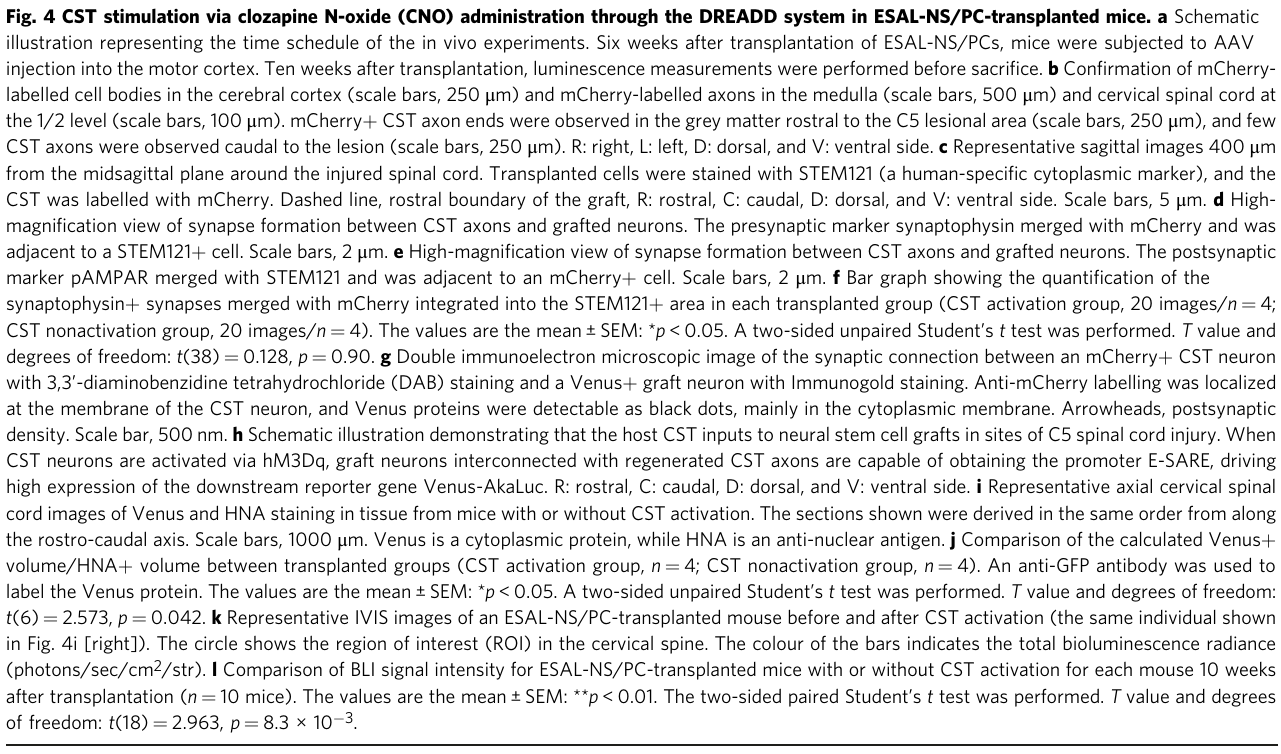
Fig. 4 CST stimulation via clozapine N-oxide (CNO) administration through the DREADD system in ESAL-NS/PC-transplanted mice. a Schematic illustration representing the time schedule of the in vivo experiments. Six weeks after transplantation of ESAL-NS/PCs, mice were subjected to AAV injection into the motor cortex. Ten weeks after transplantation, luminescence measurements were performed before sacri fi ce. b Con fi rmation of mCherry- labelled cell bodies in the cerebral cortex (scale bars, 250 μ m) and mCherry-labelled axons in the medulla (scale bars, 500 μ m) and cervical spinal cord at the 1/2 level (scale bars, 100 μ m). mCherry + CST axon ends were observed in the grey matter rostral to the C5 lesional area (scale bars, 250 μ m), and few CST axons were observed caudal to the lesion (scale bars, 250 μ m). R: right, L: left, D: dorsal, and V: ventral side. c Representative sagittal images 400 μ m from the midsagittal plane around the injured spinal cord. Transplanted cells were stained with STEM121 (a human-speci fi c cytoplasmic marker), and the CST was labelled with mCherry. Dashed line, rostral boundary of the graft, R: rostral, C: caudal, D: dorsal, and V: ventral side. Scale bars, 5 μ m. d High- magni fi cation view of synapse formation between CST axons and grafted neurons. The presynaptic marker synaptophysin merged with mCherry and was adjacent to a STEM121 + cell. Scale bars, 2 μ m. e High-magni fi cation view of synapse formation between CST axons and grafted neurons. The postsynaptic marker pAMPAR merged with STEM121 and was adjacent to an mCherry + cell. Scale bars, 2 μ m. f Bar graph showing the quanti fi cation of the synaptophysin + synapses merged with mCherry integrated into the STEM121 + area in each transplanted group (CST activation group, 20 images/ n = 4; CST nonactivation group, 20 images/ n = 4). The values are the mean ± SEM: * p < 0.05. A two-sided unpaired Student ’ s t test was performed. T value and degrees of freedom: t (38) = 0.128, p = 0.90. g Double immunoelectron microscopic image of the synaptic connection between an mCherry + CST neuron with 3,3 ’ -diaminobenzidine tetrahydrochloride (DAB) staining and a Venus + graft neuron with Immunogold staining. Anti-mCherry labelling was localized at the membrane of the CST neuron, and Venus proteins were detectable as black dots, mainly in the cytoplasmic membrane. Arrowheads, postsynaptic density. Scale bar, 500 nm. h Schematic illustration demonstrating that the host CST inputs to neural stem cell grafts in sites of C5 spinal cord injury. When CST neurons are activated via hM3Dq, graft neurons interconnected with regenerated CST axons are capable of obtaining the promoter E-SARE, driving high expression of the downstream reporter gene Venus-AkaLuc. R: rostral, C: caudal, D: dorsal, and V: ventral side. i Representative axial cervical spinal cord images of Venus and HNA staining in tissue from mice with or without CST activation. The sections shown were derived in the same order from along the rostro-caudal axis. Scale bars, 1000 μ m. Venus is a cytoplasmic protein, while HNA is an anti-nuclear antigen. j Comparison of the calculated Venus + volume/HNA + volume between transplanted groups (CST activation group, n = 4; CST nonactivation group, n = 4). An anti-GFP antibody was used to label the Venus protein. The values are the mean ± SEM: * p < 0.05. A two-sided unpaired Student ’ s t test was performed. T value and degrees of freedom: t (6) = 2.573, p = 0.042. k Representative IVIS images of an ESAL-NS/PC-transplanted mouse before and after CST activation (the same individual shown in Fig. 4i [right]). The circle shows the region of interest (ROI) in the cervical spine. The colour of the bars indicates the total bioluminescence radiance (photons/sec/cm 2 /str). l Comparison of BLI signal intensity for ESAL-NS/PC-transplanted mice with or without CST activation for each mouse 10 weeks after transplantation ( n = 10 mice). The values are the mean ± SEM: ** p < 0.01. The two-sided paired Student ’ s t test was performed. T value and degrees of freedom: t (18) = 2.963, p = 8.3 × 10 − 3